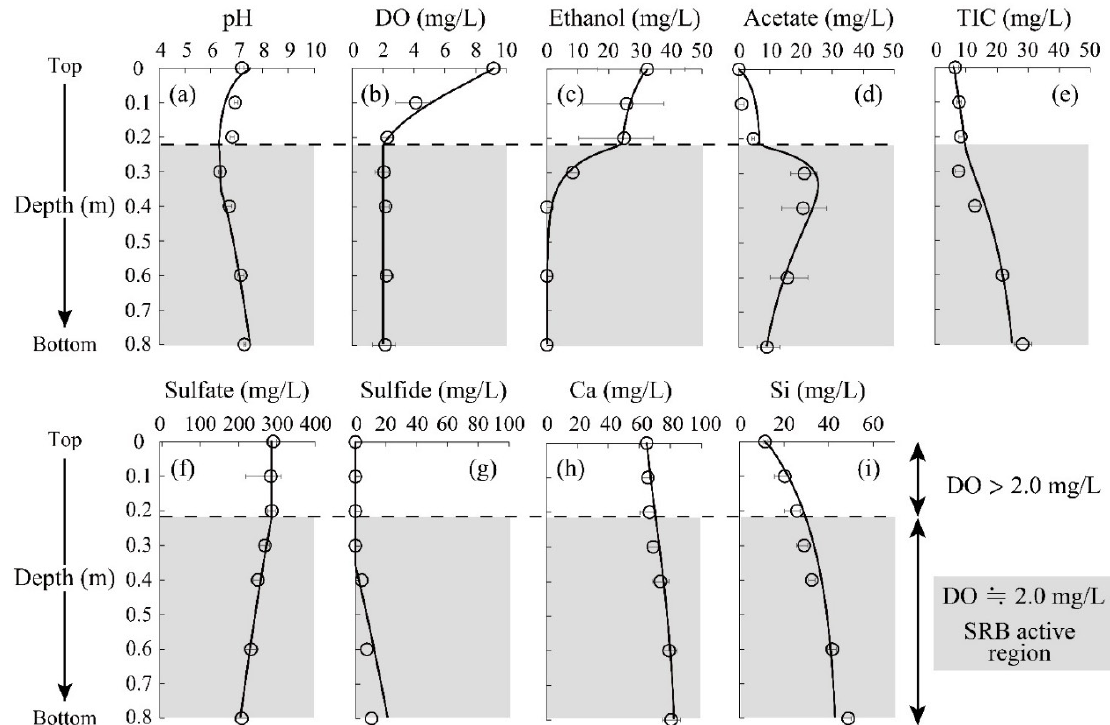
Figure 3. Changes in pH ( a ), and concentrations of DO ( b ), ethanol ( c ), acetate ( d ), TIC ( e ), sulfate ( f ), sulfide ( g ), Ca ( h ), Si ( i ) as a function of column depth. Plots and solid lines indicate the experimental results and geochemical model fitting, respectively. Error bars depict the average values of the duplicate test.